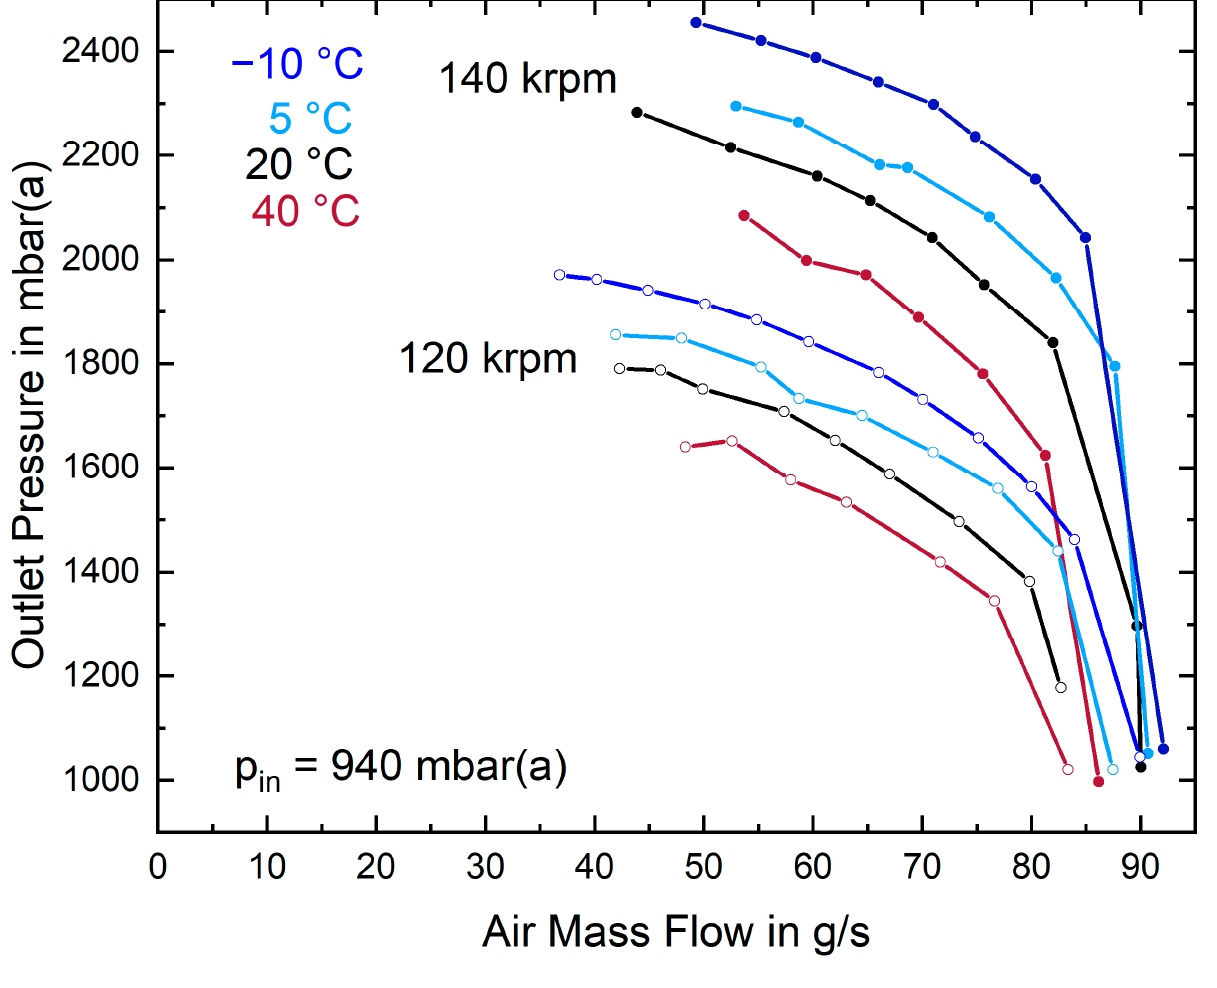
Figure 3. Absolute compressor map for varying inlet temperatures of − 10 °C (dark blue), 5 °C (light blue), 20 °C (black) and 40 °C (red) and varying compressor speeds of 120 krpm (empty points) and 140 krpm (filled points).